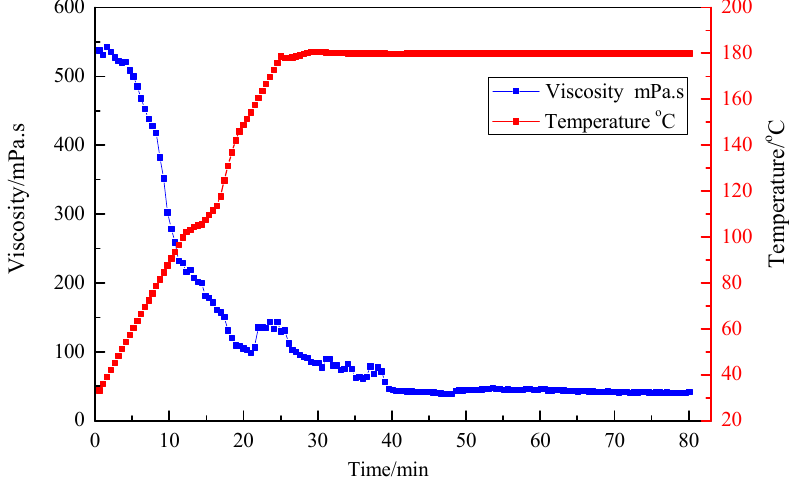
Figure 7. Shear resistance of 5 wt % VES-T with 1.2 wt % NaSal fracturing fluid at 180 °C, 170 s − 1 .